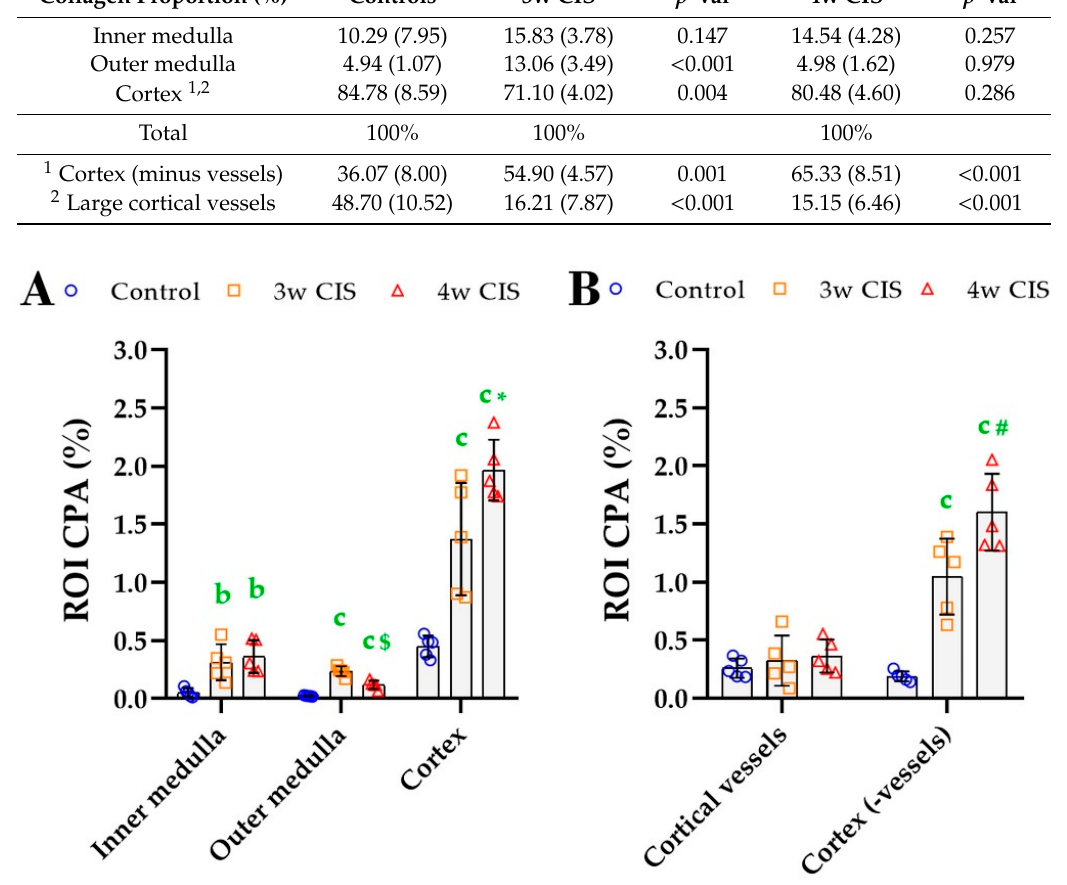
Figure 8. Kidney ROI CPA calculated using the PSR OPT detection method for each ROI ( A ) and in sub-analyzing the cortex ( B ). Mean (±SD) and one-way ANOVA with Fisher’s post-hoc test. a: p < 0.050, b: p < 0.010, c: p < 0.001 vs. controls; *: p < 0.050, # : p < 0.010, $ : p < 0.001 last time point vs. intermediate time point.